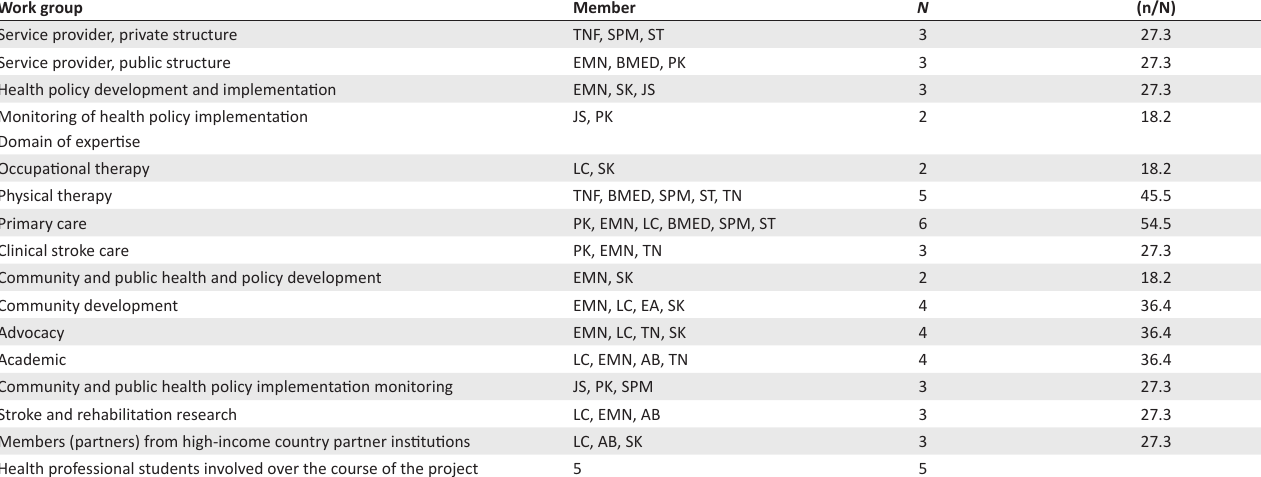
TABLE 1: Working group members’ professional background and domain of expertise. Work